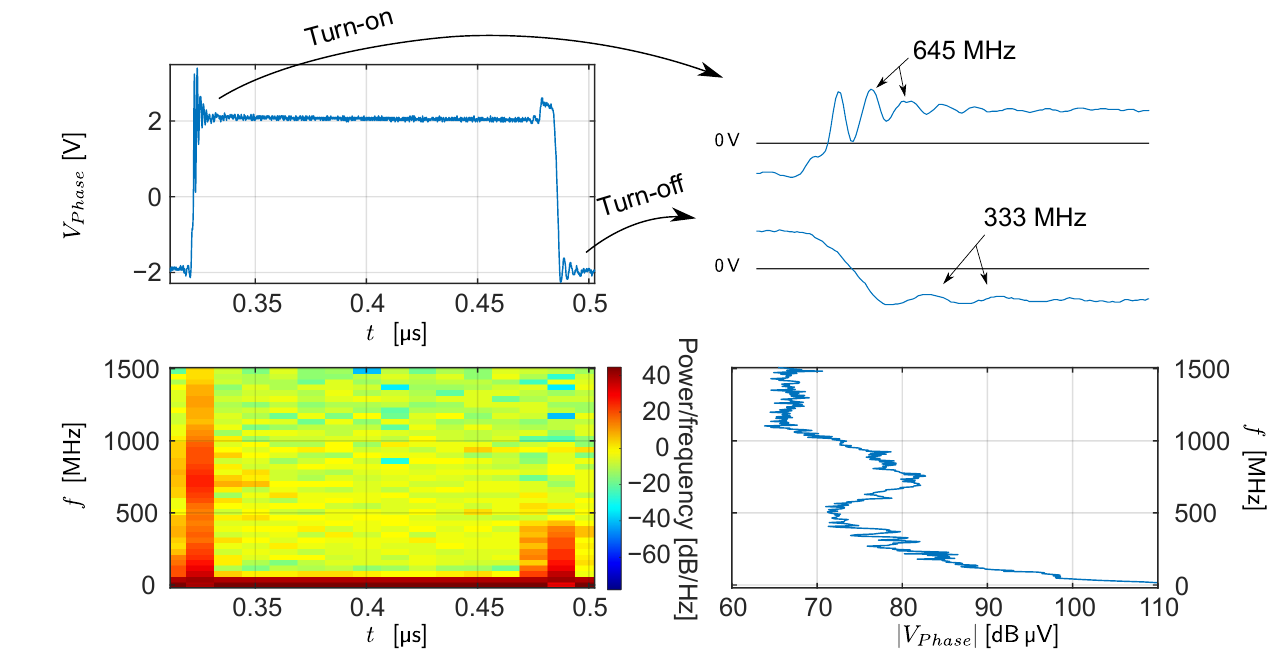
Figure 9. Measurement results on the phase node of the